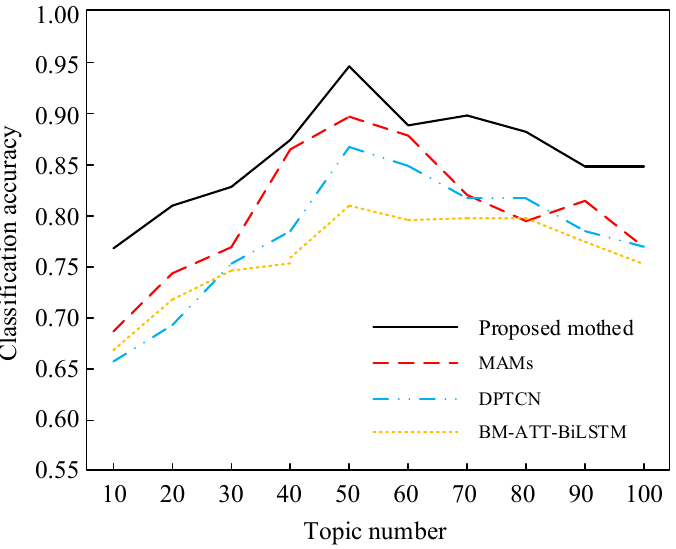
Figure 7. TC accuracy of different methods under CNT dataset [30,31,34].